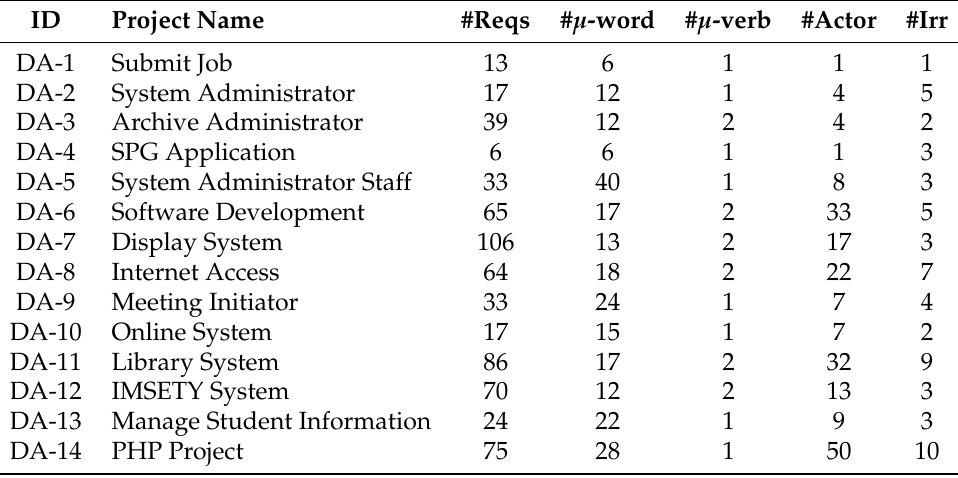
Table 1. Recapitulation of the Requirements in Each